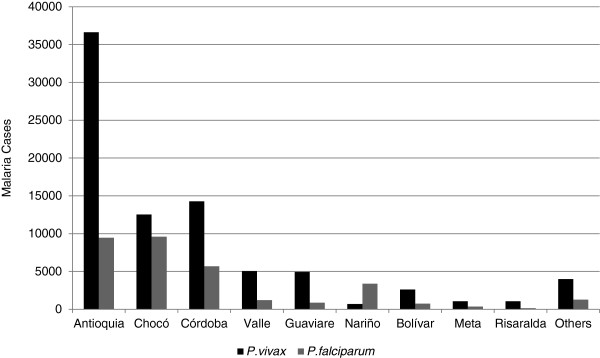
Distribution of malaria by department, Colombia, 2010.